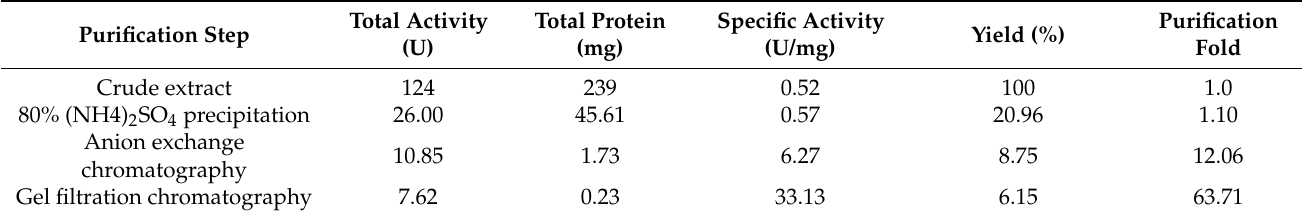
Table 1. Purification steps of TtCel7A from T. terrestris